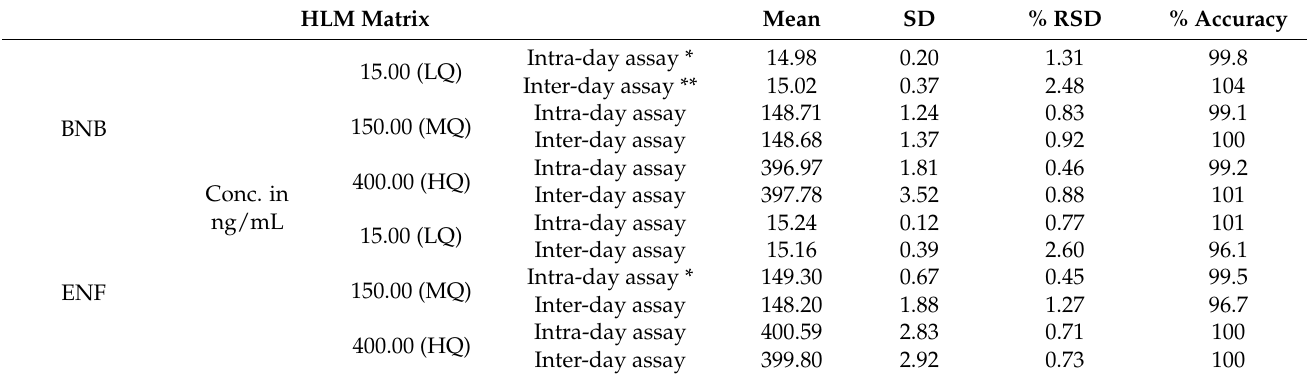
Table 2. Intra-day and inter-day accuracy and precision.